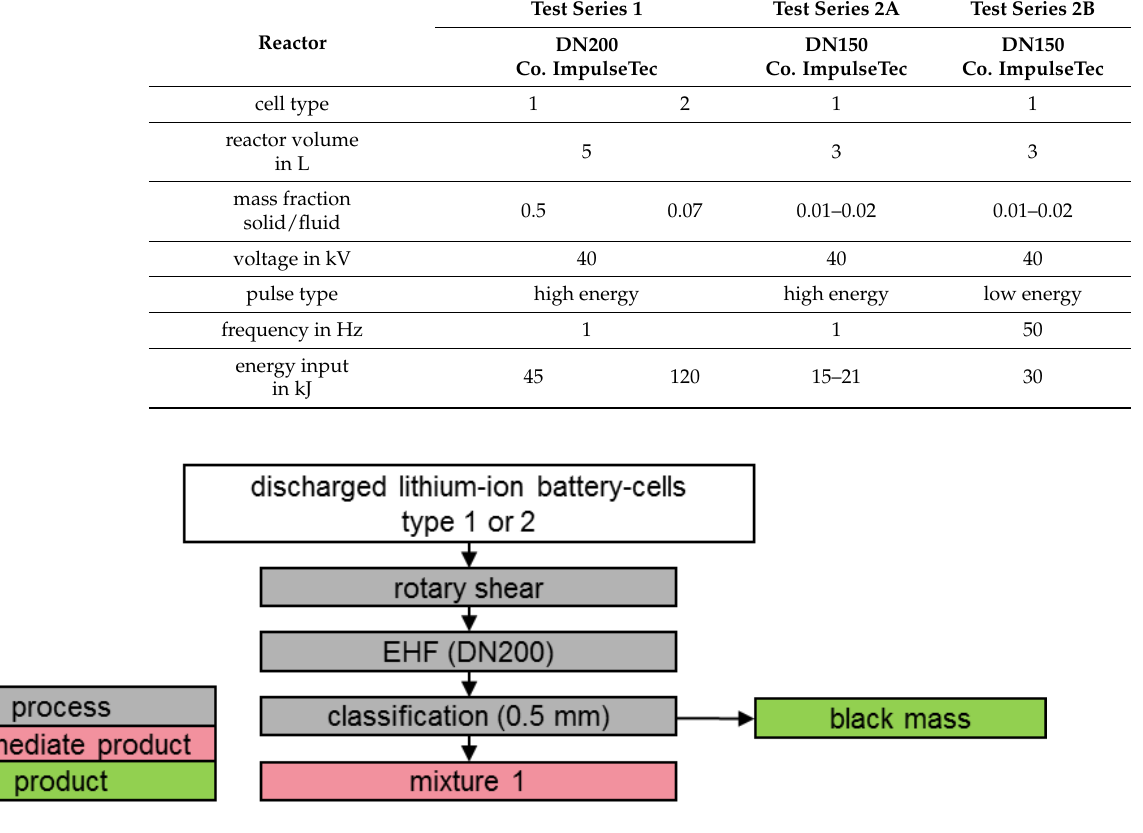
Figure 3. Schematic illustration of test series 1. Table 2. Overview of the EHF test parameters.